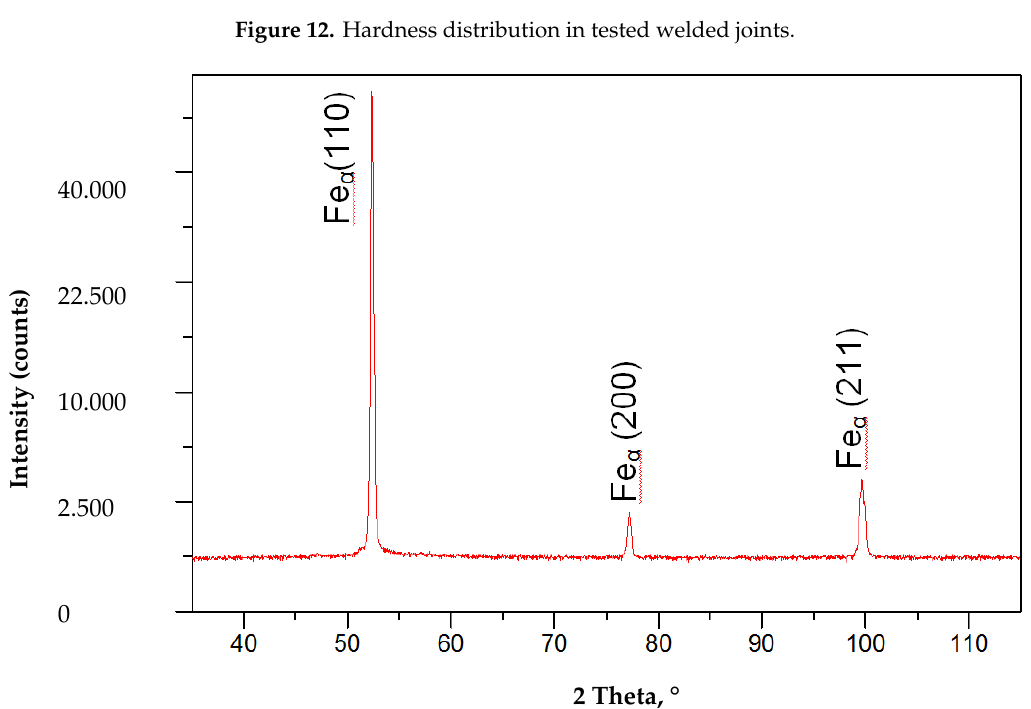
Figure 13. X-ray diffraction of a laser S700MC steel butt joint welded in the PC position with 5 kJ/cm linear energy.